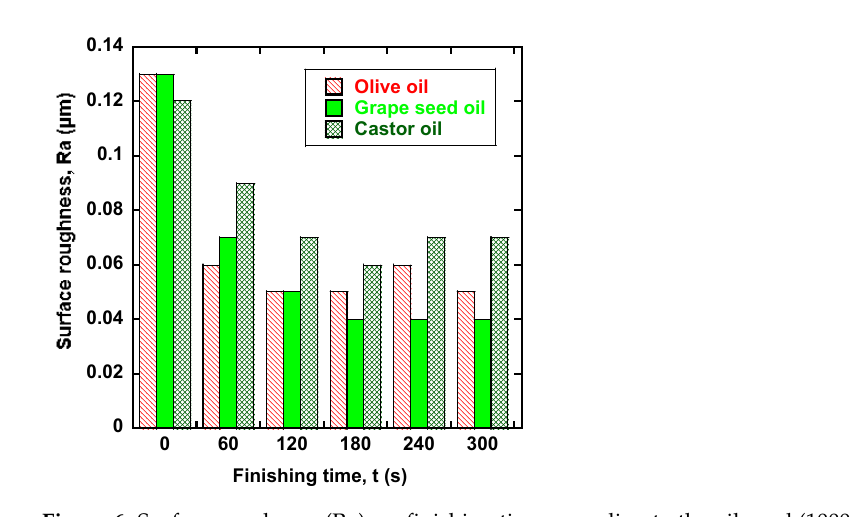
Figure 6. Surface roughness (Ra) vs. finishing time according to the oil used (1000 rpm).